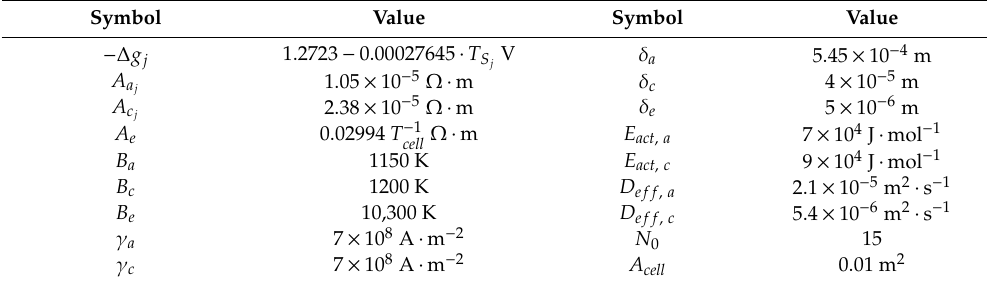
Table 2. Electrochemical reaction